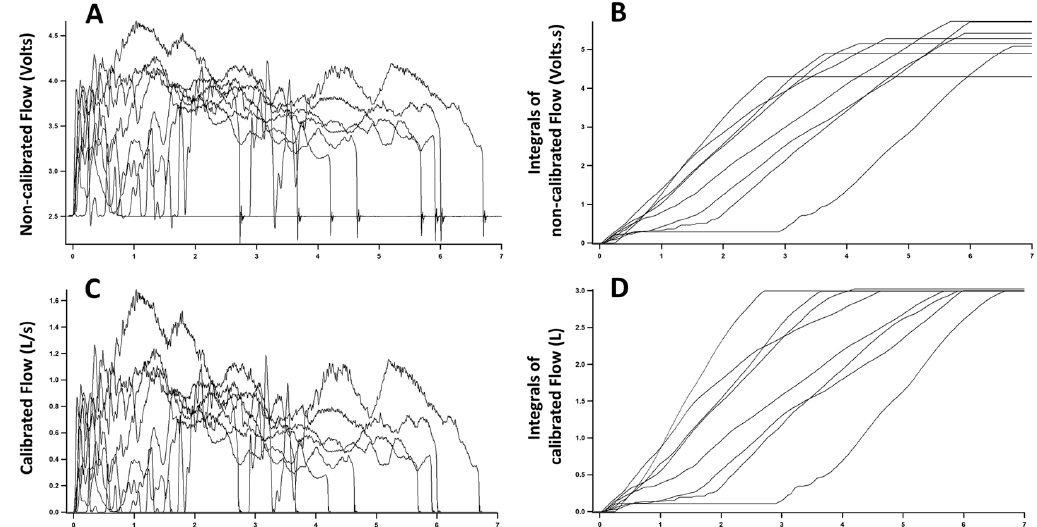
Figure 2. Calibration trials and procedures. The graphs represent recordings of 8 trials with a 3 L syringe (calibration syringe) emptied through the flow sensor at different speeds. Signals recorded by the flow sensor prior to calibration are displayed in ( A ) and were integrated over time ( B ). Although all trials were done with the same syringe, the integrals have different final values, underscoring the nonlinearity of the flow sensor. A software algorithm was used to find parameters for a power function minimizing the difference between integrals [Flow = A*(voltage b )]. ( C ) Shows flow signals after application of calibration parameters. ( D ) Shows the integrals of calibrated flow signals. Note that after calibration parameters were used, integrals are equal among each other and equal to the volume of the syringe (compare to B ).